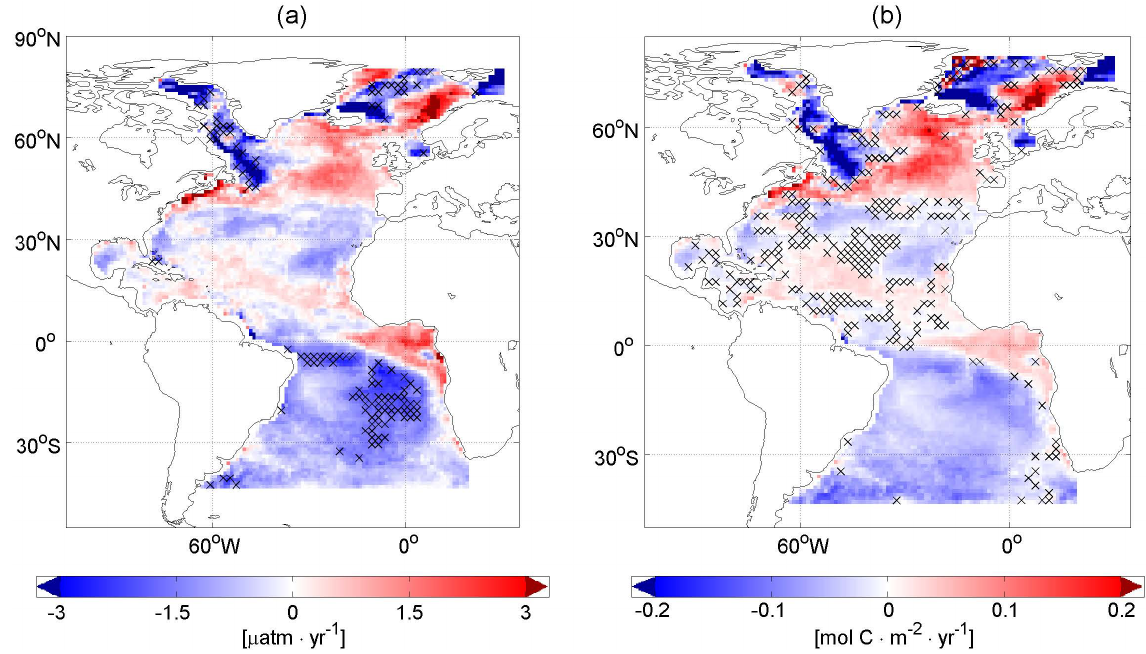
Fig. 11. Linear trends (a) in sea surface p CO 2 relative to that in the atmosphere and (b) in the CO 2 flux over the period 1998–2007. The relative trend in sea surface p CO 2 was computed by subtracting the atmospheric mean trend. Areas with cross-hatch indicate where the trend is outside the 95% confidence level ( p ≥ 0 . 05). Trends were derived by first applying a 12 month running mean to each pixel to deseasonalize the data and then calculating the slope of a linear fit to these deseasonalized data.